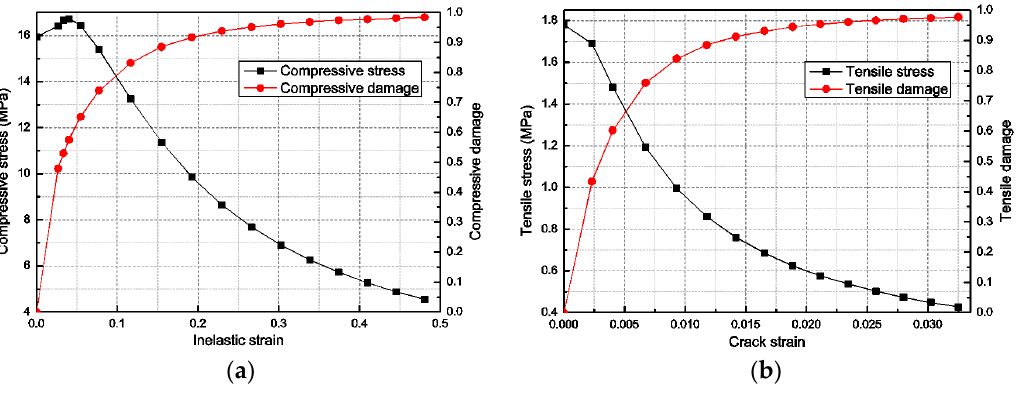
Figure 3. Concrete material properties: ( a ) compressive properties; and ( b ) tensile properties.